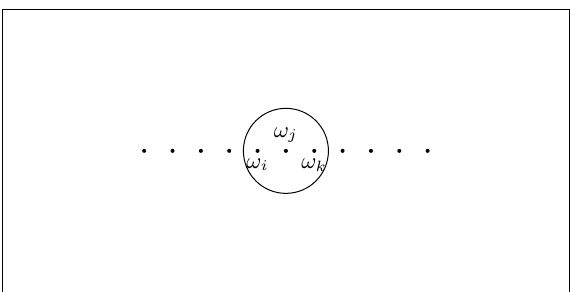
Figure 3: Each point on a line excluding the first and last point has two neighbors within a disk, i.e., a preceding point and a succeeding